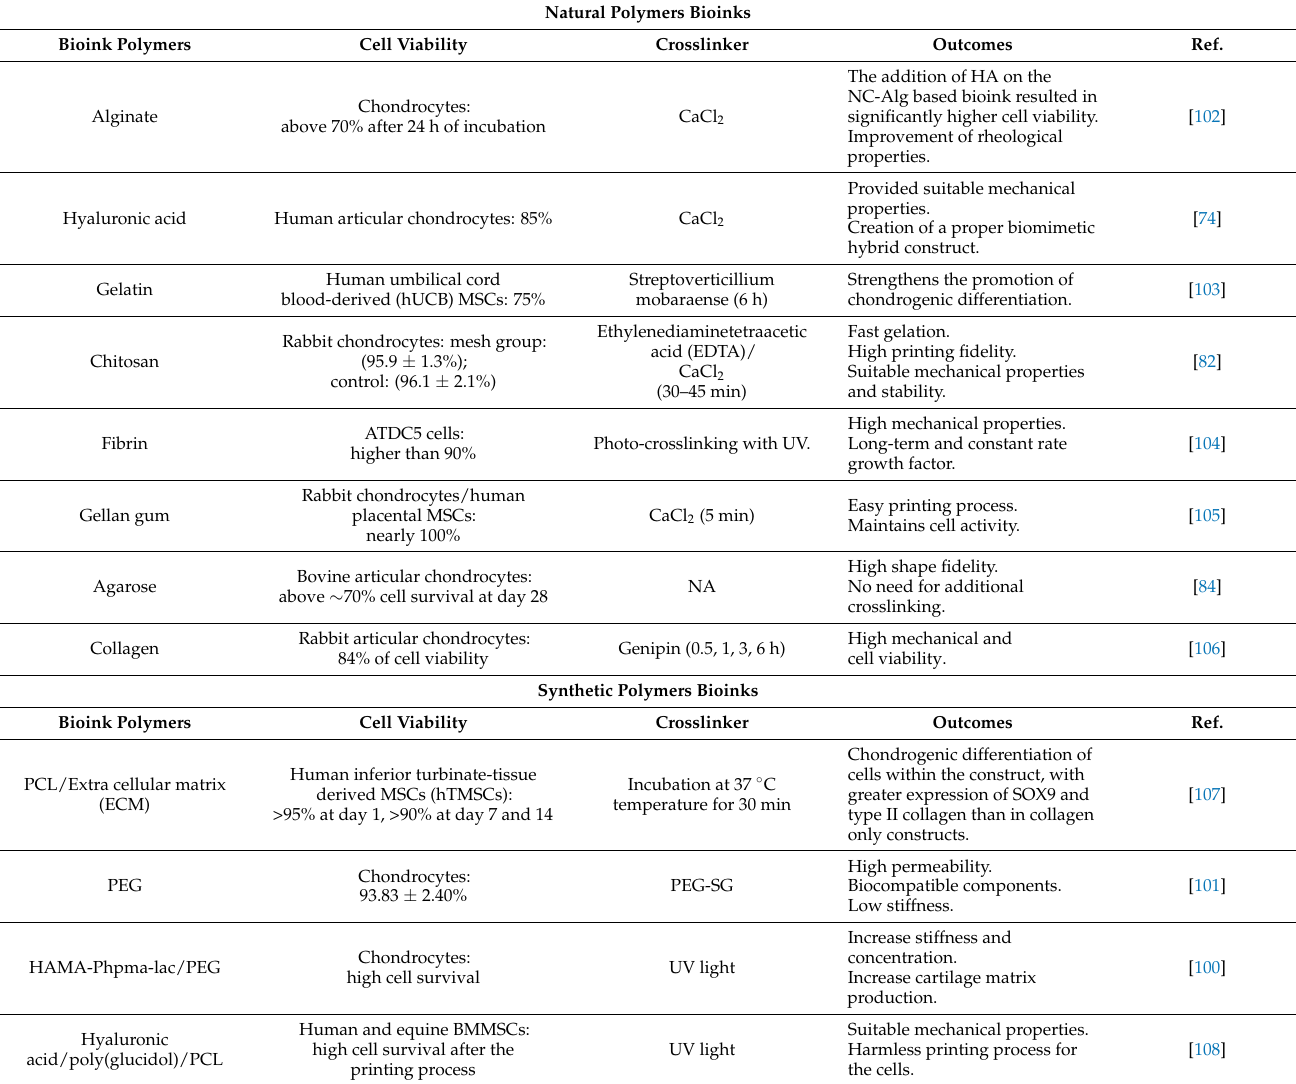
Table 1. Natural and synthetic biomaterials-based bioinks for cartilage tissue engineering